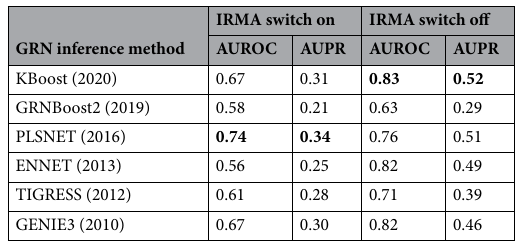
Table 1. IRMA dataset benchmark. The best performance in each column is in bold.